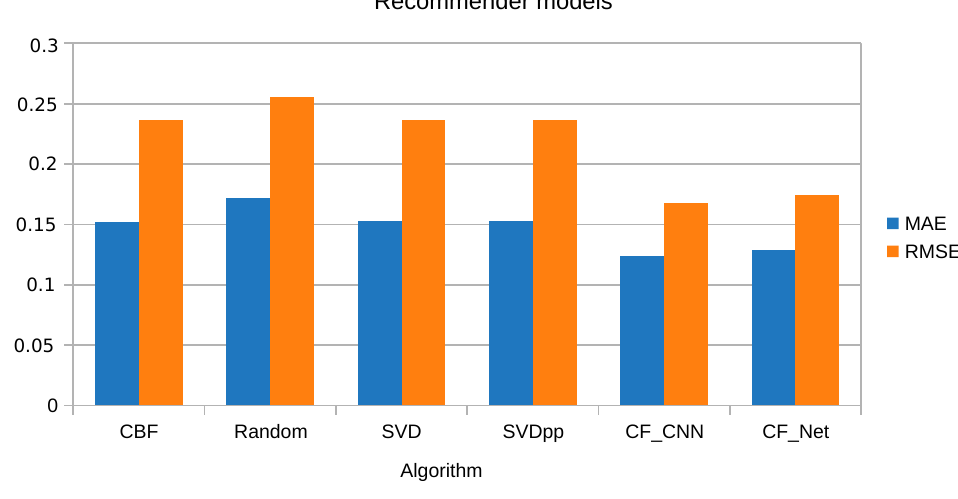
Figure 15. TERS-ER Evaluation.